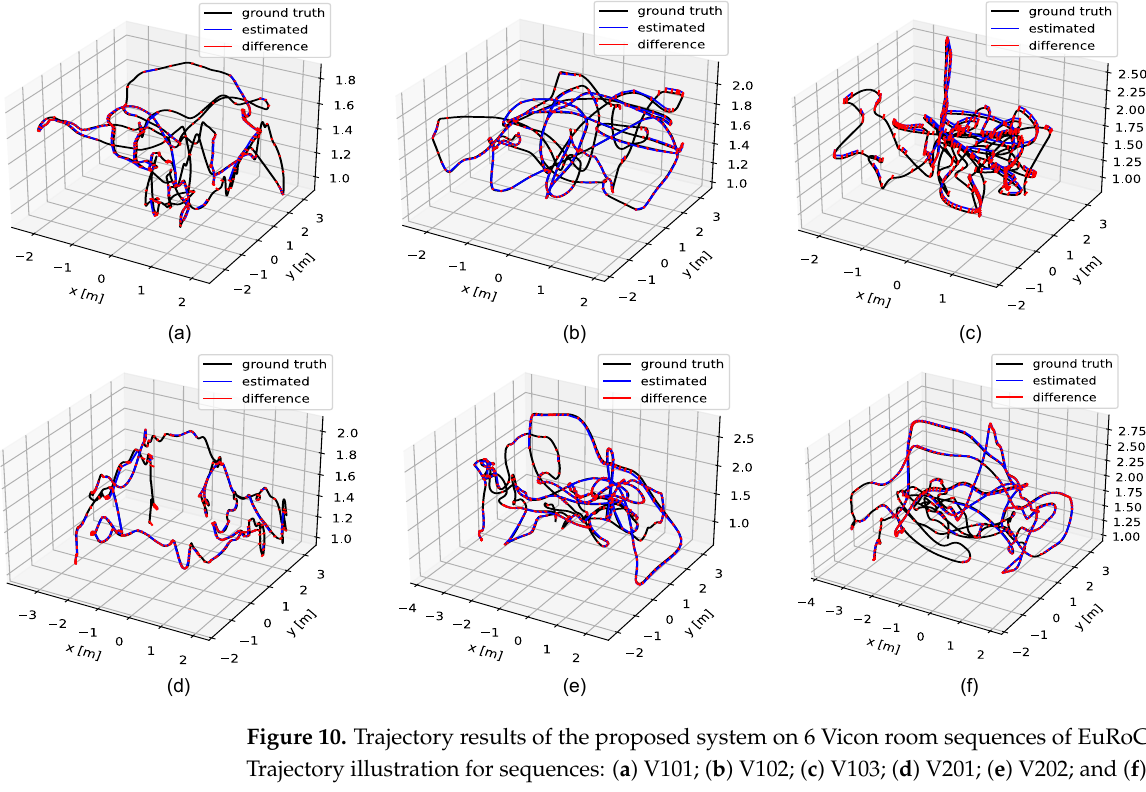
Figure 10. Trajectory results of the proposed system on 6 Vicon room sequences of EuRoC dataset. Trajectory illustration for sequences: ( a ) V101; ( b ) V102; ( c ) V103; ( d ) V201; ( e ) V202; and ( f ) V203.